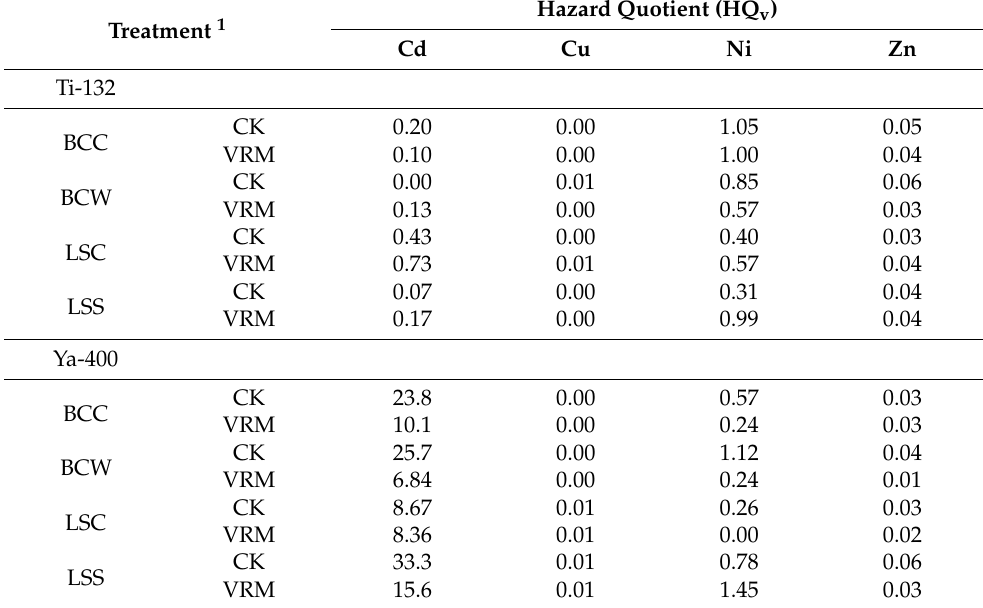
Table 4. The hazard quotients (HQ v ) of Cd, Cu, Ni, and Zn for the oral intake of pak choi and lettuce grown under different